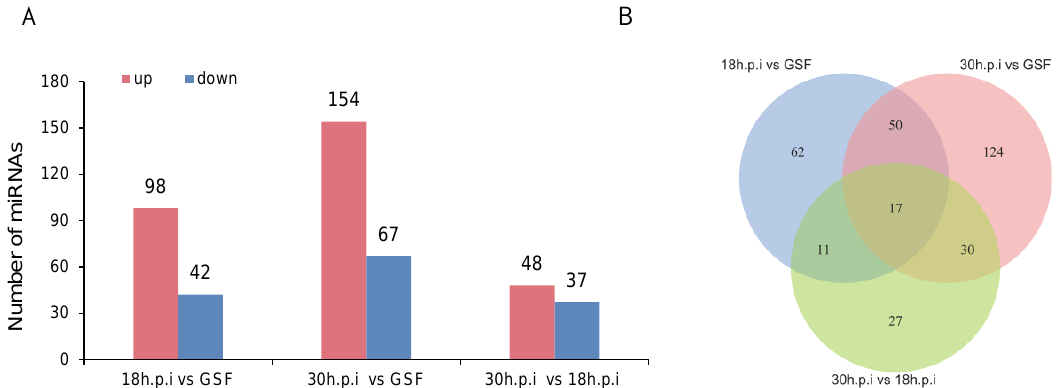
Figure 2. Di ff erentially expressed miRNAs in 18h.p.i vs. GSF, 30h.p.i vs. GSF, and 30h.p.i vs. 18h.p.i. Figure 2. Differentially expressed miRNAs in 18h.p.i vs GSF, 30h.p.i vs GSF, and 30h.p.i vs 18h.p.i. ( A ) Bar chart of DE miRNAs in 18h.p.i vs. GSF, 30h.p.i vs. GSF, and 30h.p.i vs. 18h.p.i. ( B ) Venn A. Bar chart of DE miRNAs in 18h.p.i vs GSF, 30h.p.i vs GSF, and 30h.p.i vs 18h.p.i. diagram of DE miRNAs in 18h.p.i vs. GSF, 30h.p.i vs. GSF, and 30h.p.i vs. B. Venn diagram of DE miRNAs in 18h.p.i vs GSF, 30h.p.i vs GSF, and 30h.p.i vs 18h.p.i.